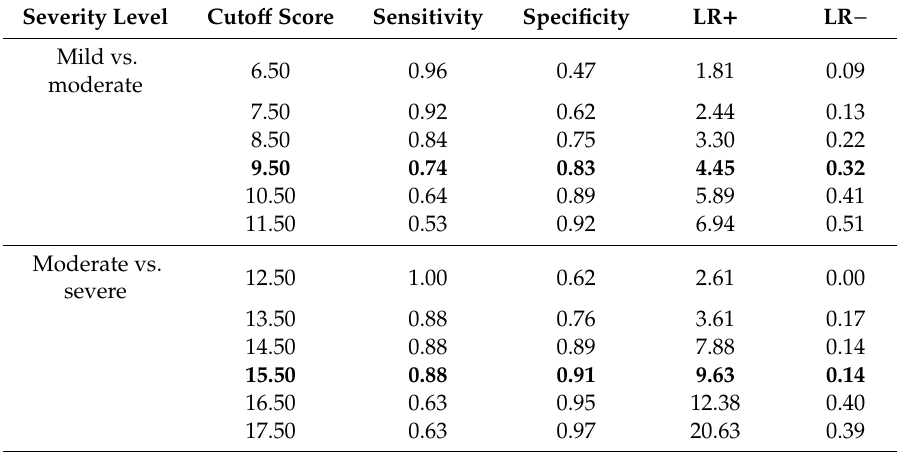
Table 3. Cutoff scores of the AIS for insomnia.